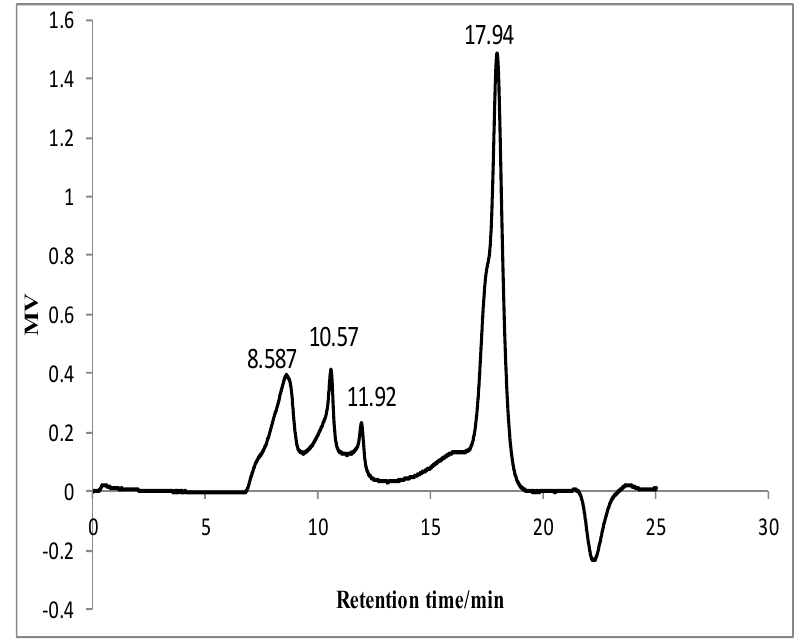
Figure 1. HPLC chromatograms of guava leave (GLP).